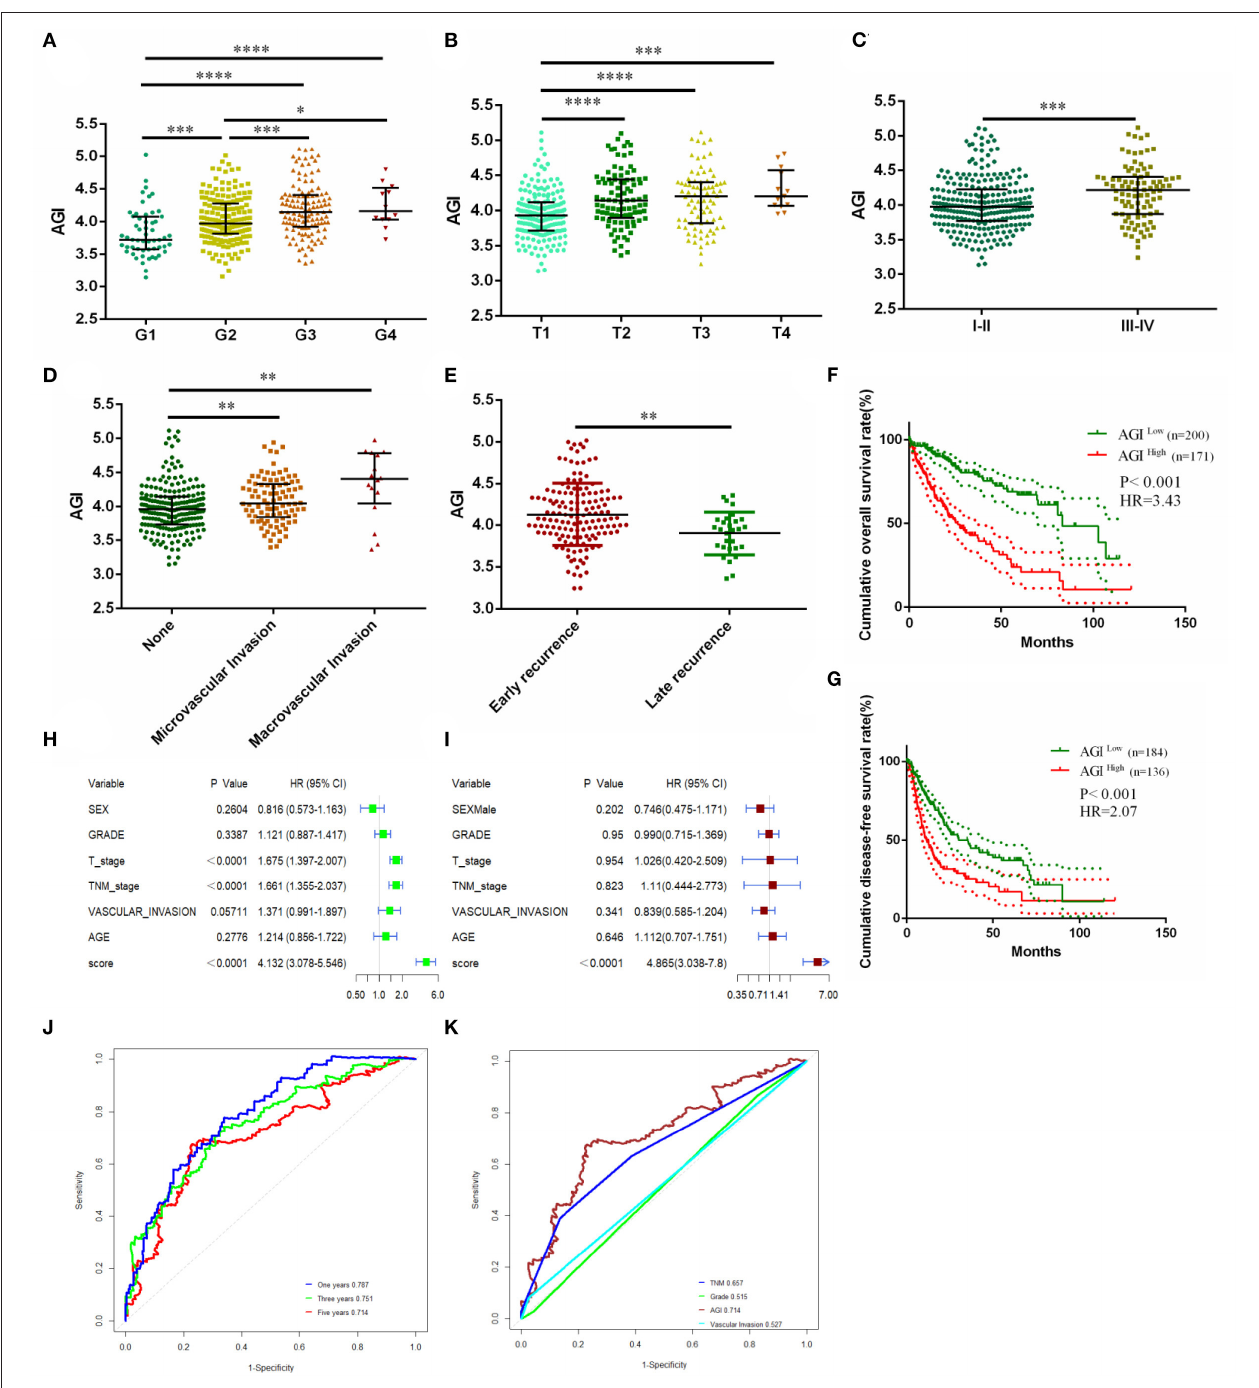
FIGURE 4 | Clinicopathological significance and prognosis prediction value of the AGI. (A) Tumor differentiation grade. (B) T stage. (C) Tumor–node–metastasis (TNM) stage. (D) Vascular invasion status. (E) Recurrence status. (F) Kaplan–Meier plot analysis of overall survival (OS) in the high and low AGI groups. (G) Kaplan–Meier plot analysis of disease-free survival (DFS) in the high and low AGI groups. (H,I) Forest plot showing the prognostic value of the AGI and clinical characteristics using univariate (H) and multivariate (I) analysis. (J) Time-dependent receiver operating characteristic (ROC) analysis comparing the AGI in predicting the 1-, 3-, and 5-year OS. (K) Time-dependent ROC analysis comparing the AGI and clinical characteristics in 5-year OS. * P < 0.05, ** P < 0.01, *** P < 0.001, **** P < 0.0001.